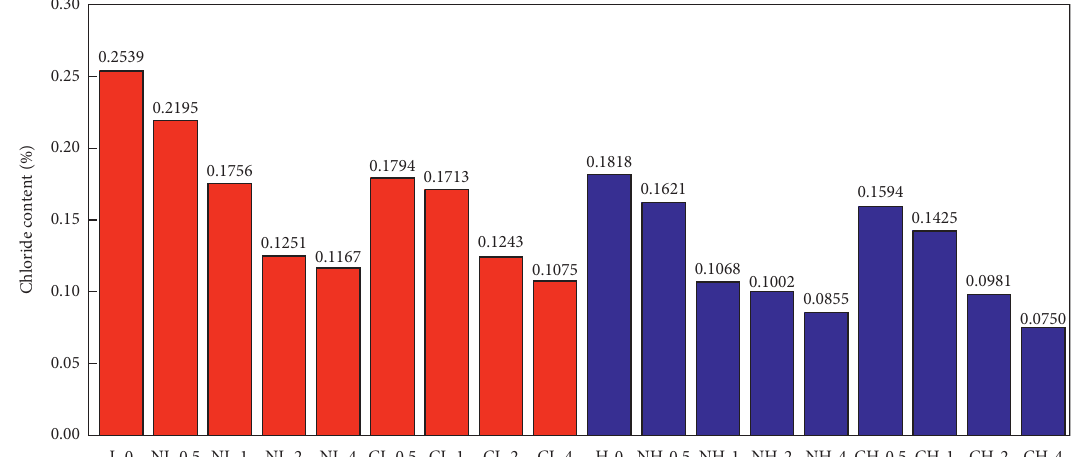
Figure 3: The chloride ion content of concrete 9 ∼ 11 mm away from the exposed surface of concrete.